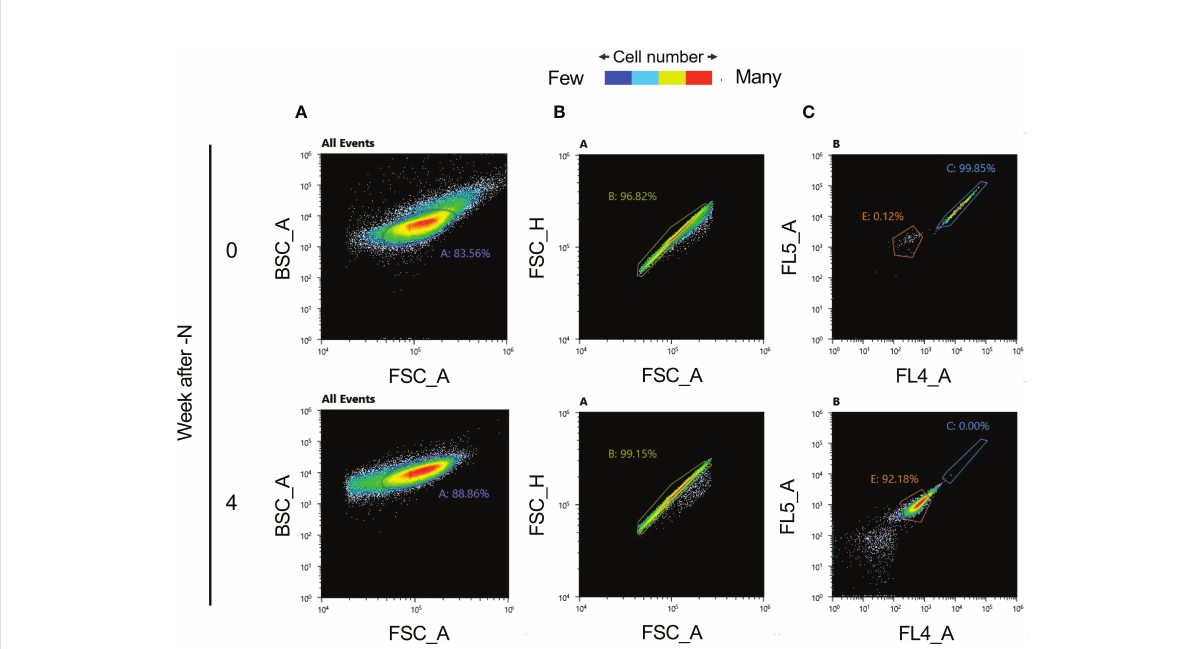
FIGURE 4 Auto fl uorescence values and cell isolation before and after N-depletion, obtained using an SH800S Cell Sorter (SONY). (A) Back-scatter area (BSC_A) and forward-scatter area (FSC_A) scatter plots for each cell following N-depletion, (100,000 measured cells). The number A denotes the percentage of cells inside the purple circle (gate A). (B) FSC_A and FSC_H scatter plot. Scatter plot of forward-scatter area (FSC_A) and forward-scatter height (FSC_H) based on each cell following N-depletion. For the start of N-depletion, there are 83,556 plots; for four weeks of N-depletion, there are 88,856 plots. Gate B (the yellow circle) denotes single cells based on scatter plot information. The number B denotes the percentage of cells inside the yellow circle. For the start of N-depletion, there are 80,903 plots; for four weeks of N-depletion, there are 88,105 plots. (C) Auto fl uorescence scatter plot, for the single cells identi fi ed in panel B, at 720 ± 30 nm (FL5 detector) and 665 ± 15 nm (FL4 detector). For the start of N-depletion, there are 80,903 plots; for four weeks of N-depletion, there are 88,105 plots. Gates C (blue circle) and E (orange circle) denote cell populations whose auto fl uorescence is mostly as expected before N-depletion, or after four weeks of N-depletion, respectively. The numbers C and E denote percentages of cells inside the blue and orange circles,